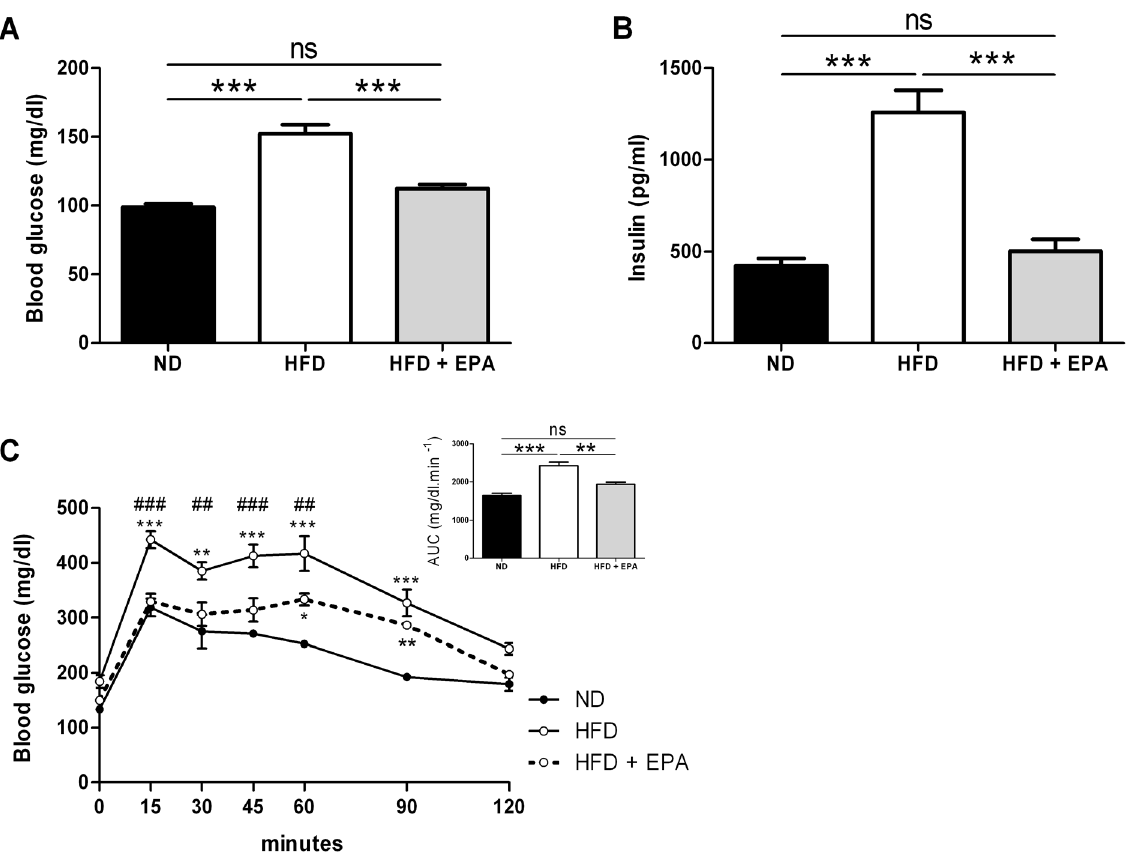
Figure 3. Protective effect of EPA supplementation on the HFD-induced impaired glucose metabolism. (A) Glycemia and (B) insulinemia in 6 h-fasted mice fed a ND (n=12), a HFD (n=14) or a HFD + EPA (n=14) after 10 weeks. Results represent mean 6 SEM. ***p , 0.001, (C) OGTT curves and area under the curve (AUC) of glycemia monitored during OGTT performed on 6 h fasted (during light period) mice after 9 weeks of diet in ND (n=4), HFD (n=6) and HFD + EPA (n=6) mice. Results represent mean 6 SEM. *p , 0.05, **p , 0.01, ***p , 0.001 vs ND; and ## p , 0.01, ### p , 0.001 vs HFD.